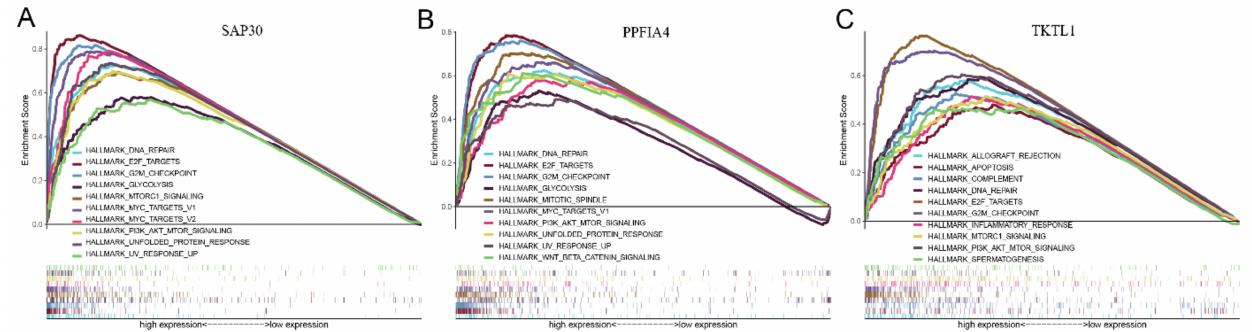
Figure 7. GSEA enrichment analysis of three hypoxia-related mRNAs in the predicted ceRNA regulatory axes. ( A ) SAP30, ( B ) PPFIA4, ( C )